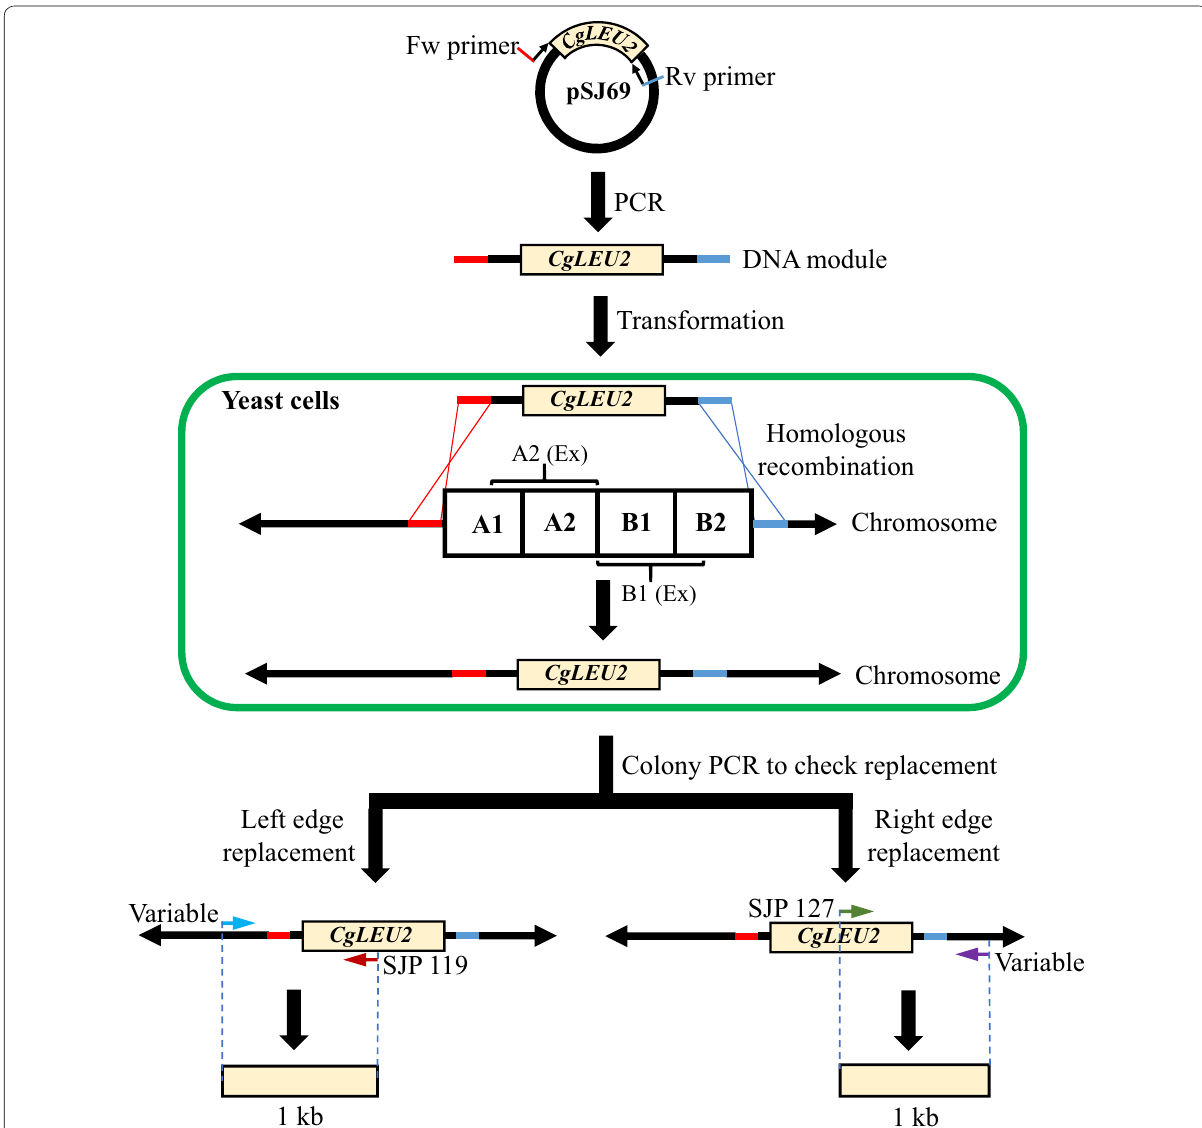
Fig. 1 Overview of replacement analysis of target region. Target region was replaced by DNA module harboring CgLEU2 . For amplification of DNA module, forward and reverse primers were designed to anneal with the plasmid pSJ69 and DNA module was amplified by PCR. DNA module has 50 bp homology sequence with the target region (harboring A1, A2, A2 (Ex), B1, B1 (Ex) and B2 sub-regions) in both edges. After introduction of DNA module by transformation into yeast cell, target region was supposed to be replaced by the DNA module through homologous recombination. Replacement of left edge of target region was checked by colony PCR with specific forward primers depending upon the target regions and common reverse primer SJP 119 which leads to PCR product of 1 kb. On the other hand, replacement of right edge of target region was checked with common forward primer SJP 127 and specific reverse primers depending upon respective regions which also amplified 1 kb